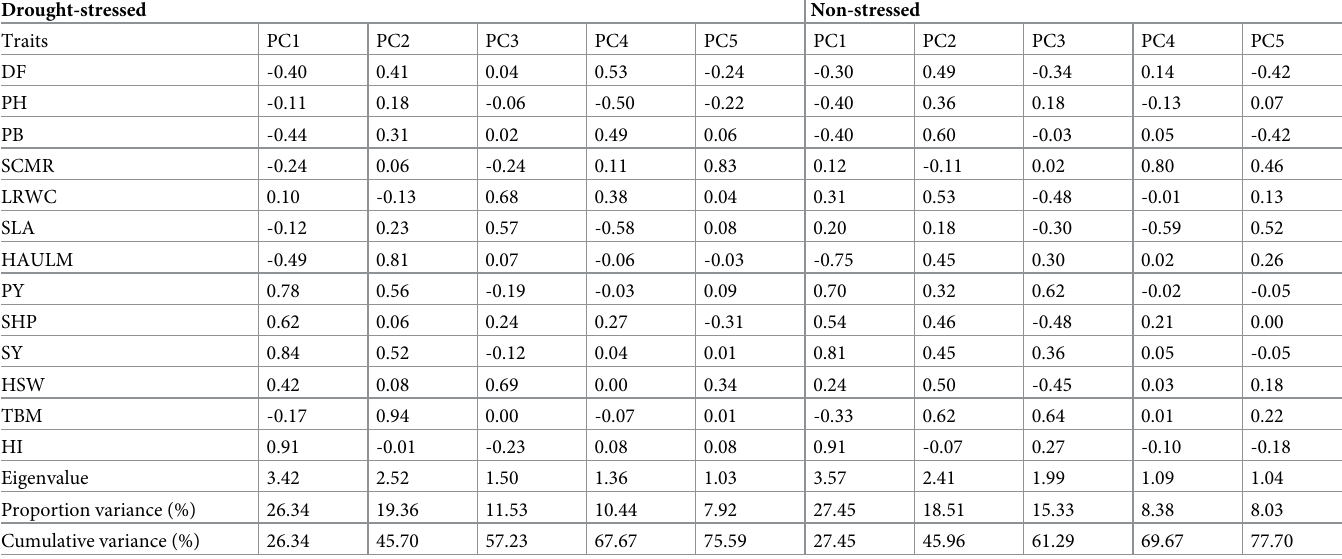
Table 4. Principal component scores, Eigenvalues, variances of 13 phenotypic traits among 100 groundnut genotypes evaluated under drought-stressed and non- stressed conditions across two seasons. Drought-stressed Traits